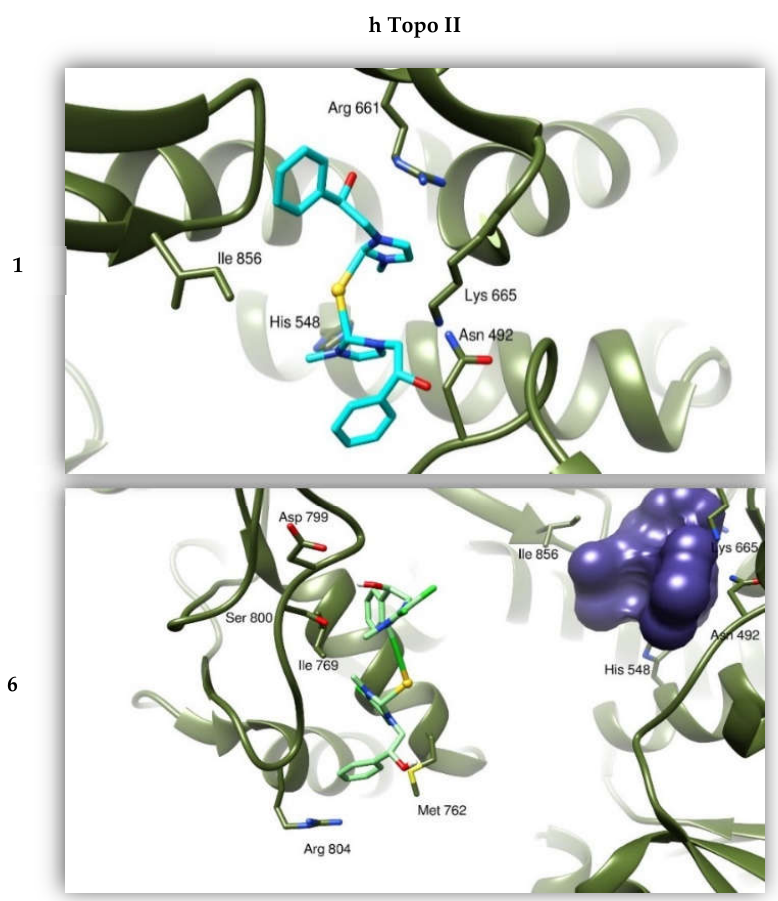
Figure 7. Binding modes of compounds 1 and 6 with hTopo I and hTopo II. The proteins are depicted as tanned and olive-green ribbons, respectively. Compound 1 is drawn as light blue sticks, while compound 6 as green sticks. As reference, the violet bubble indicates the position of compound 1 with respect to compound 6 in binding hTopo II.